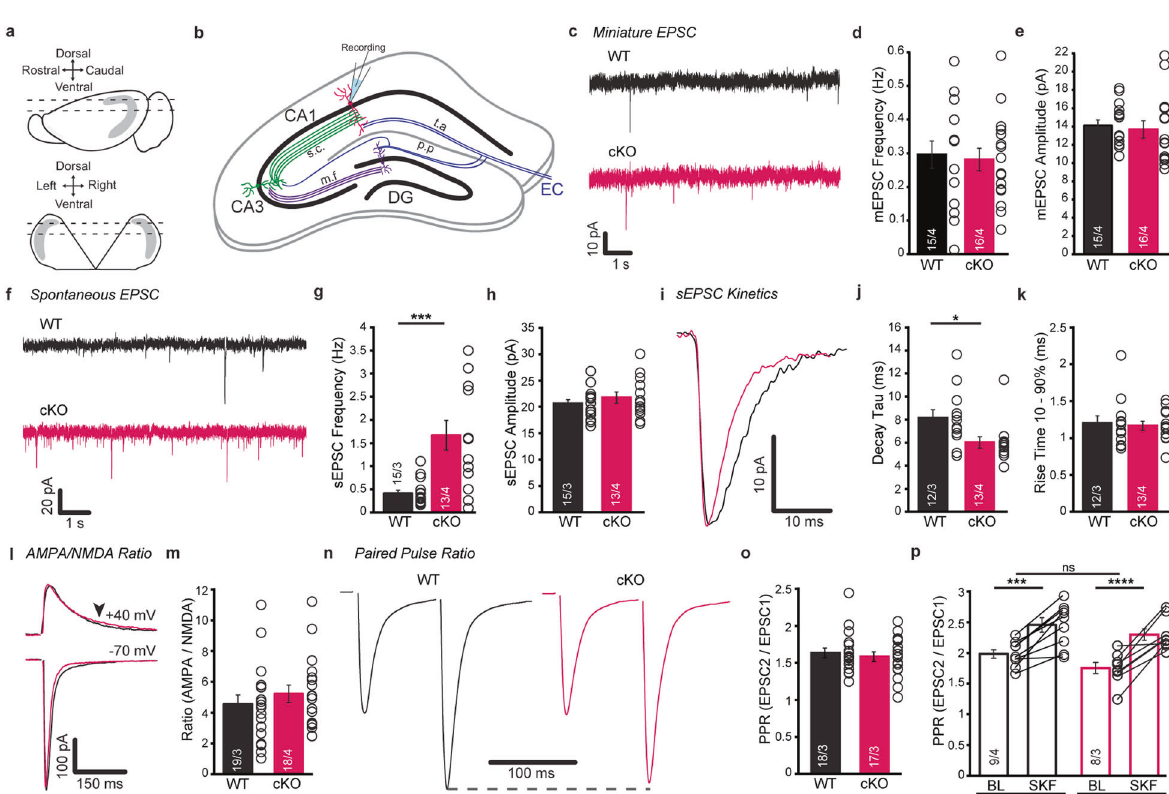
Fig. 5 Conditional deletion of Nrxn2 increases network activity in the CA3-CA1 circuit. a , b CA1 pyramidal cells were recorded from acute semi-horizontal slices. Illustrations show semi-horizontal hippocampal slices prepared from a 12-degree angle ( a ) and inputs are preserved in slices ( b ). Dashed lines denote the range of slices collected for recording. c – e Conditional deletion of Nrxn2 does not impact basal excitatory synaptic transmission. c Representative mEPSC traces. Summary graphs of frequency ( d ) and amplitude ( e ). f – h Conditional deletion of Nrxn2 increases the frequency of sEPSCs. f Representative sEPSC traces. Summary graphs of frequency ( g ) and amplitude ( h ). i – k Conditional deletion of Nrxn2 decreases the decay time constant (tau) of sEPSCs. i Representative traces of averaged sEPSC event. Summary graphs of decay tau ( j ) and rise time ( k ). l , m Conditional deletion of Nrxn2 does not impact the ratio of AMPA- and NMDA-mediated currents. l Representative traces of evoked EPSCs. n Summary graph of AMPA/NMDA ratio. n , o Conditional deletion of Nrxn2 does not impact the release probability of glutamate, assessed by measuring paired-pulse ratio (PPR). n Representative traces of excitatory PPR. o Summary graph of PPR. p Conditional deletion of Nrxn2 does not impact GABA B -mediated function on glutamate release probability. Summary graph of PPR before (baseline, BL) and after application of SKF (SKF97541, 20 µM). Number of neurons/mice is listed inside the bar graphs. Open circles represent each cell. Data is represented as means ± SEM for 4 WT and 4 Nrxn2 cKO for ( d , e ); 3 WT and 3 Nrxn2 cKO for ( g , h, j , k , m ); 3 WT and 3 Nrxn2 cKO for ( o ); 4 WT and 3 Nrxn2 cKO ( p ). Statistical assessments performed by unpaired two-tailed Student ’ s t -test by comparing Nrxn2 cKO to WT mice with * p < 0.05, *** p < 0.001,**** p < Increased frequencies of sEPSCs and sIPSCs in Nrxn2 cKO mice naïve (unstimulated) Nrxn2 cKO mice suggests that these naïve suggest that Nrxn2 deletion alters basal network activity. These immature spines could potentially become mature upon stimula- changes were independent of changes in neurotransmitter release tion or learning to form stable synaptic connections. This data probability or changes in the relative contribution of AMPA and corresponds to our observations in electrophysiology recordings NMDA receptors. Further analysis of the tri-synaptic hippocampal and behavioral tasks where naïve Nrxn2 cKO exhibit abnormal circuit by measuring the population fi eld potential (excitatory phenotypes but can appear normal upon stimulation or learning.